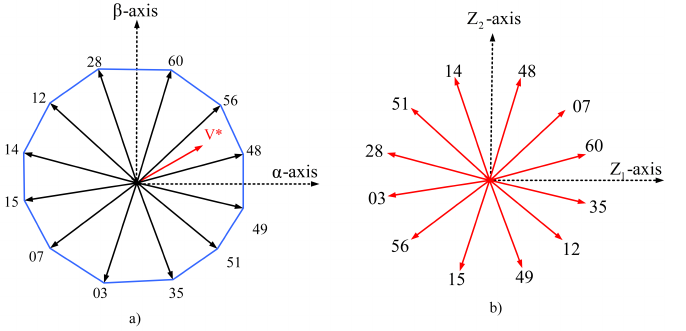
Figure 16. Voltage vector map in stationary frame. ( a ) Projection of voltages on αβ plane. ( b ) Projection of voltages on z 1 z 2 plane